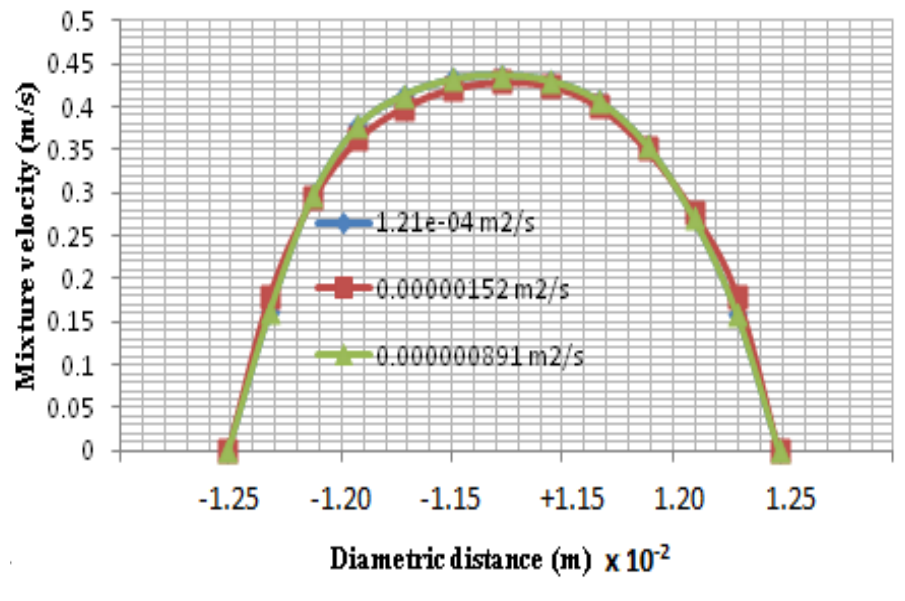
Figure 7. Oil phase kinematic viscosity changes affecting the mixture velocity